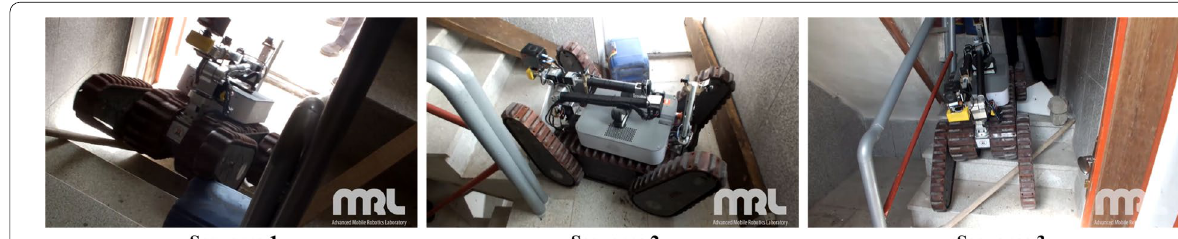
Fig. 27 The robot is completing repetitions on stairs with debris